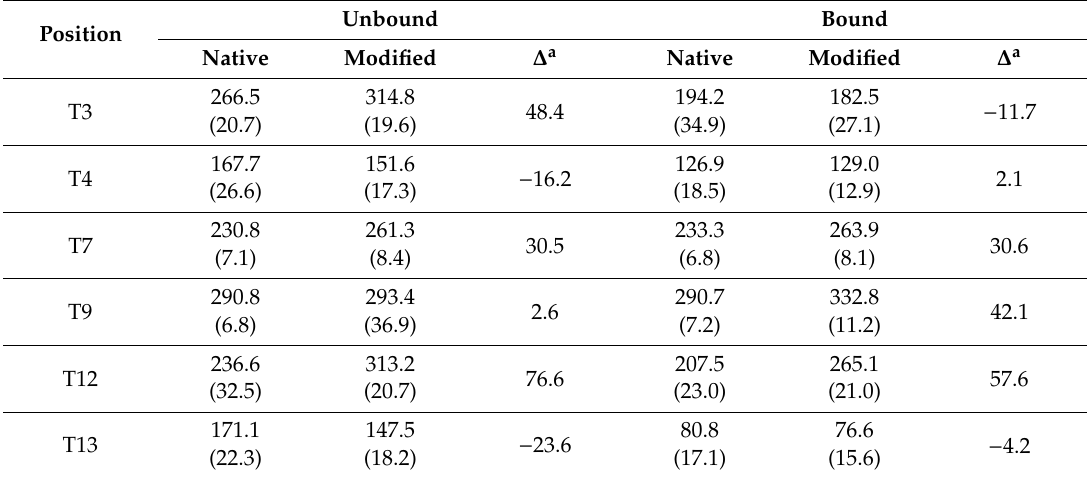
Table 2. Average (and standard deviation in parentheses) solvent accessible surface area (SASA, Å 2 ) of native or modified T in each TBA position throughout 0.5 µ s molecular dynamics (MD)